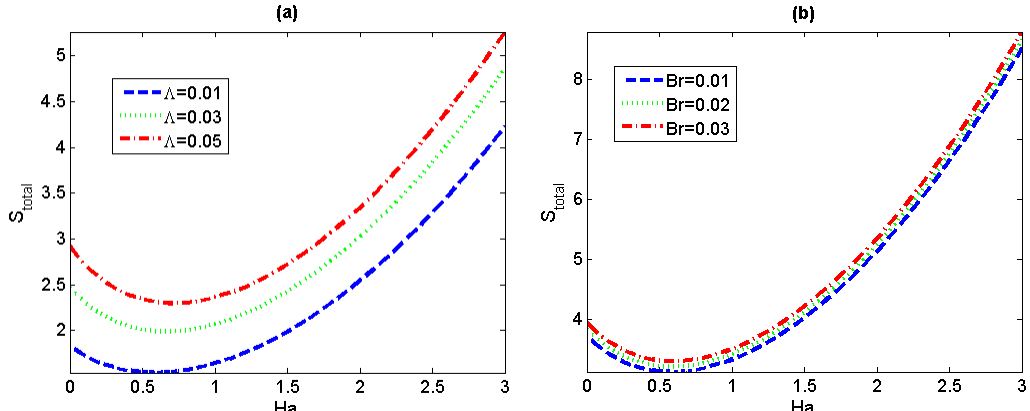
Figure 9. Variations of total entropy generation S total for different value of Λ and Br . ( S = 1) ( a ) Br = 0.005, Pe = 0.5; ( b ) Λ = 0.01, Pe = 0.5.